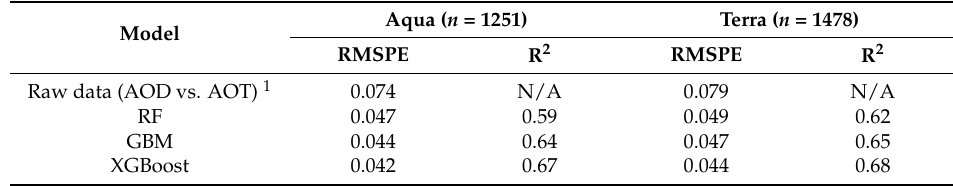
Table 2. Performance predicting AOD-AOT on a test